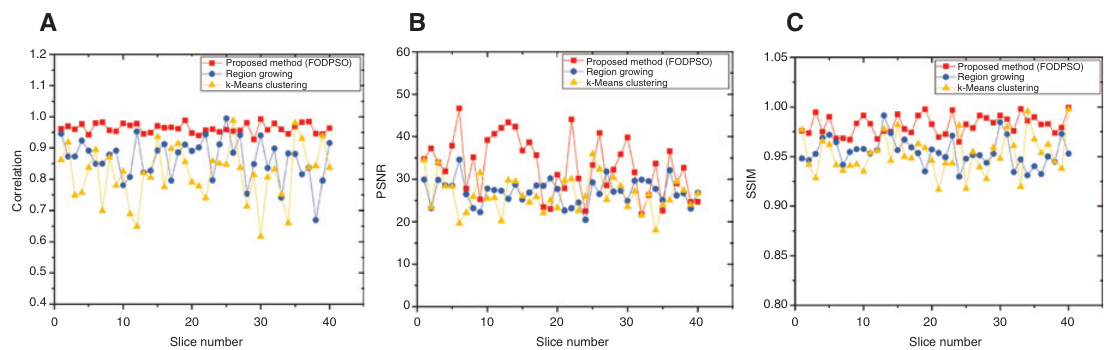
Figure 5: Comparison of Performance Evaluation Results Between Region Growing, k-Means Clustering, and Our